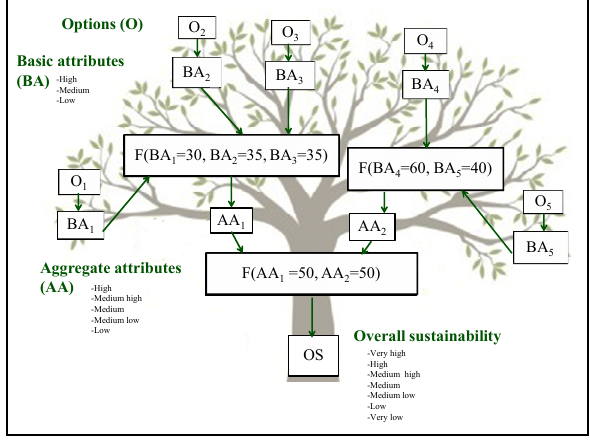
Figure 2. Example of a typical multi-attribute DEXi model, indicating basic attributes (BA), options (O), aggregate attributes (AA), utility function (F), and overall sustainability (OS).